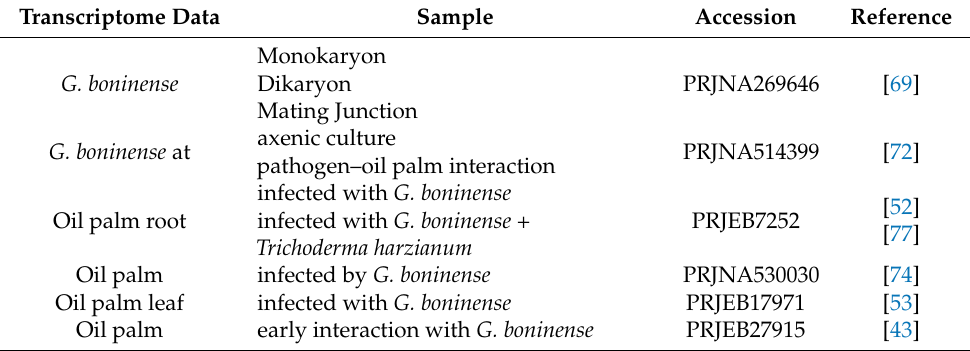
Table 3. Current G. boninense -related transcriptomic data are available in the public